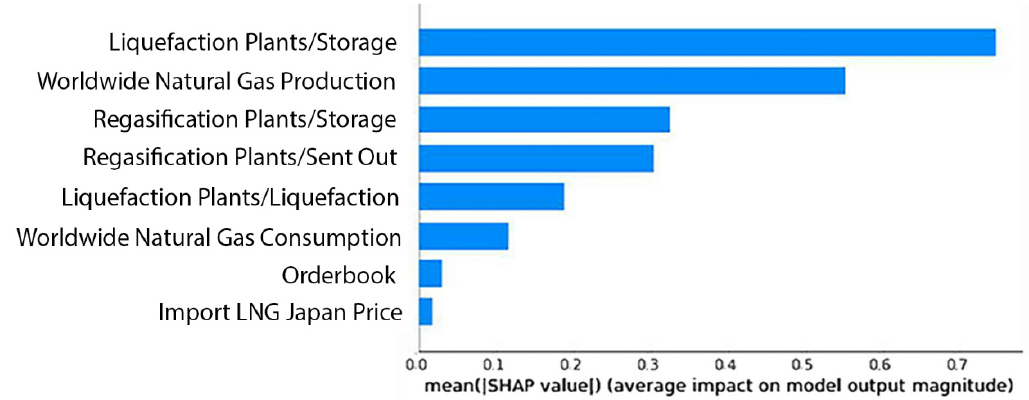
Figure 4. SHAP summary plot for LNG 145K CBM spot rate: 2 months of GFFN model.